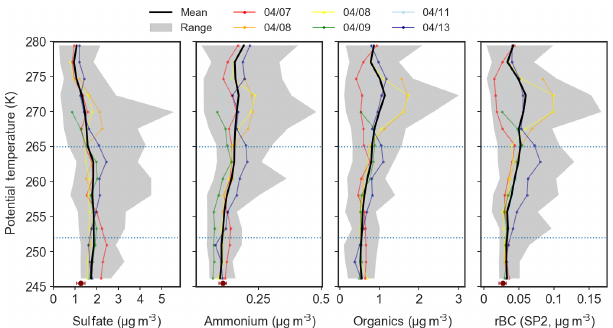
Figure 5. Mean potential temperature profiles of relative aerosol composition, including mass fractions of sulfate (mf SO aerosol (mf OA ), refractory black carbon (mf rBC ), and ammonium (mf NH ), in the polar dome observed during 7–13 April 2015. 4 Coloured lines indicate the mean profile for each flight, the black line represents the mean profile over all six flights, and gray shad- ing shows the range of observations in each potential temperature bin.